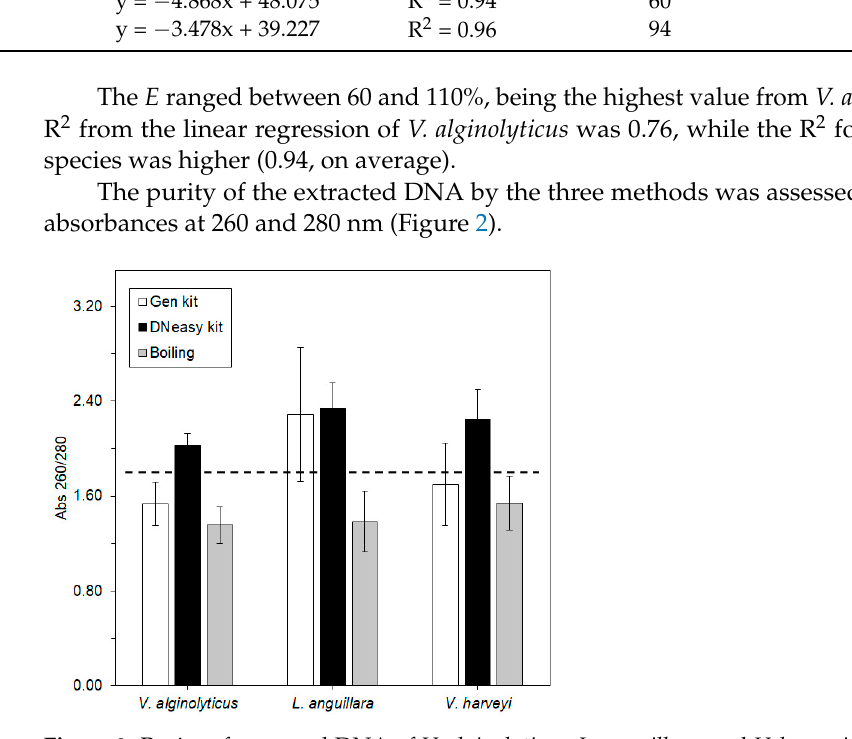
—Gen kit, —DNeasy kit,